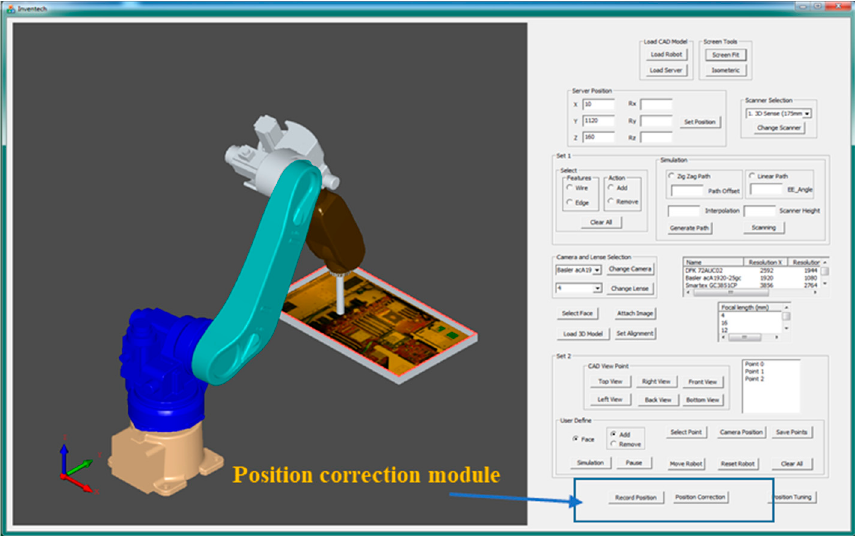
Figure 9. Robot-guided AOI inspection system.